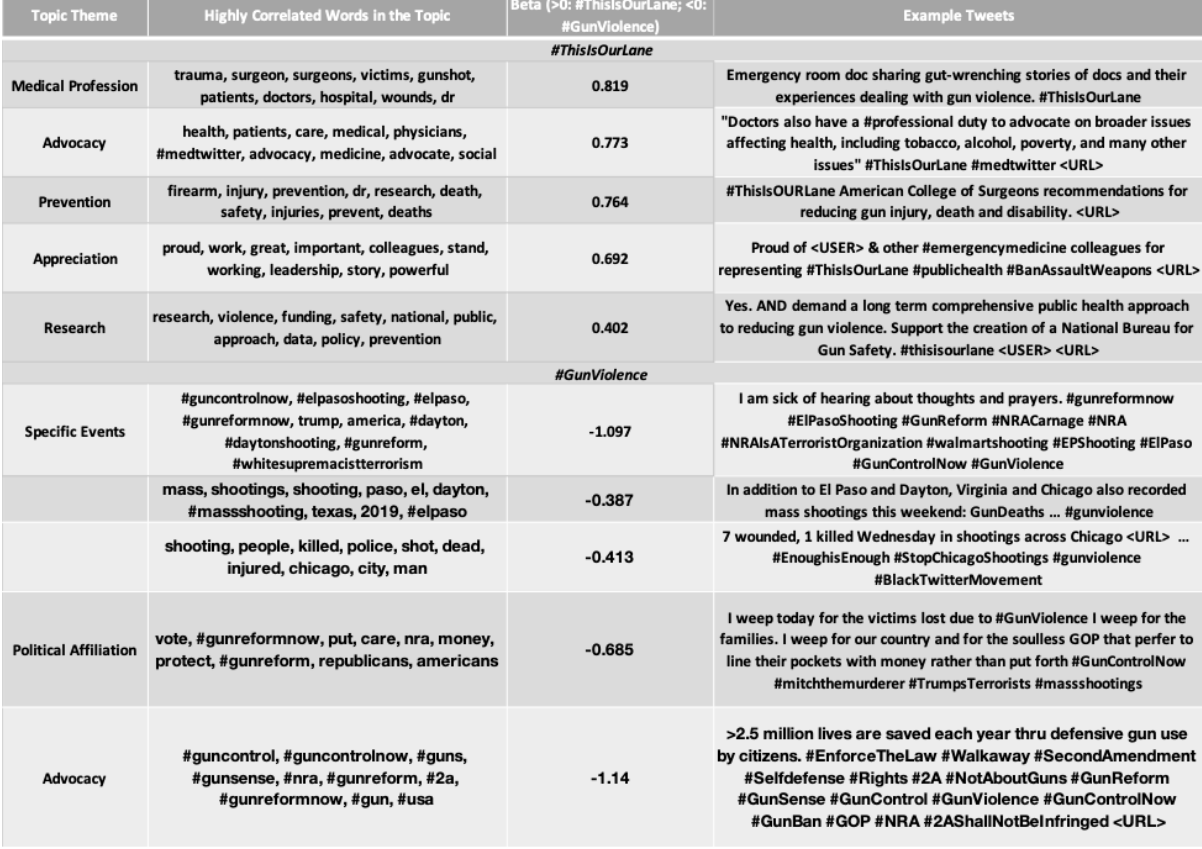
Figure 4. Highly correlated topics with mention of #ThisIsOurLane vs. #GunViolence. Beta indicates the strength of association of each topic. Top words and example paraphrased tweets for each topic are shown. Topics are statistically significant at p<.05, Benjamin Hochberg correction.